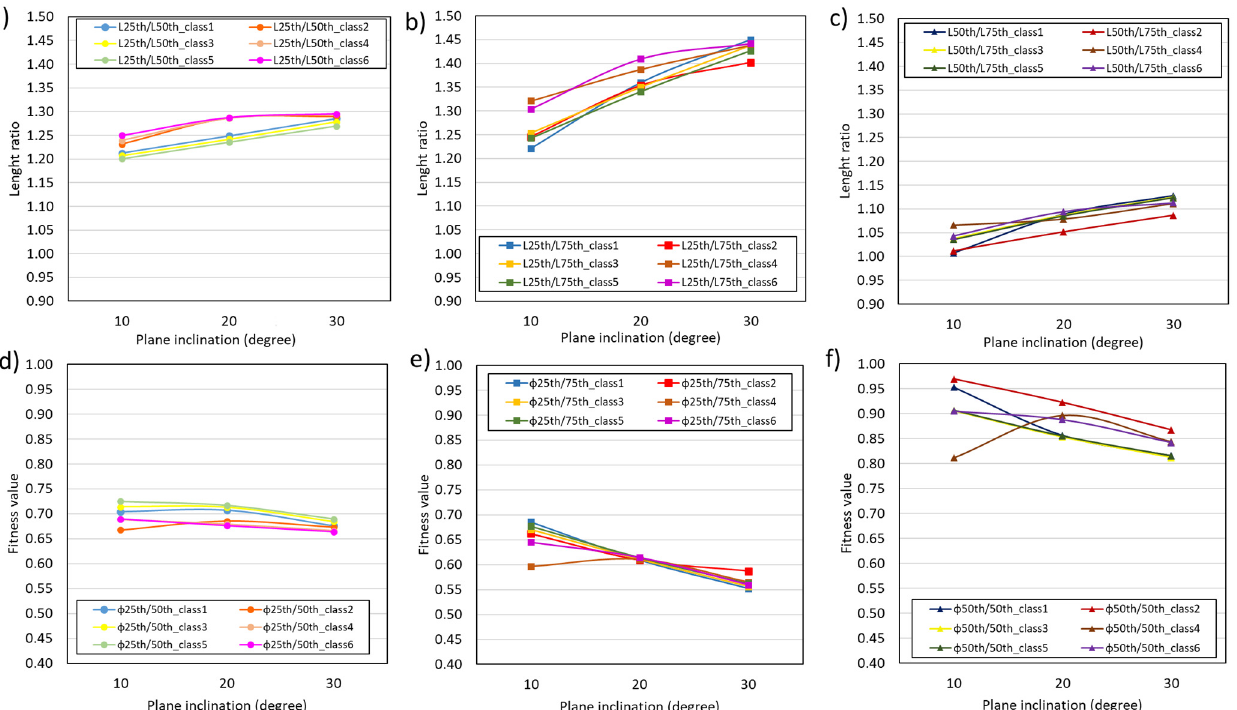
Figure 9. Diagrams showing the length ratios L ( a – c ) and fitness values ϕ ( d – f ) between simulated lava derived from the characteristic curves on all of the inclined planes (10°, 20°, 30°). Calculations were performed between the 25th and 50th curves (circles), the 25th and 75th curves (square), and the 50th and 75th curves (triangles) for each eruptive class.